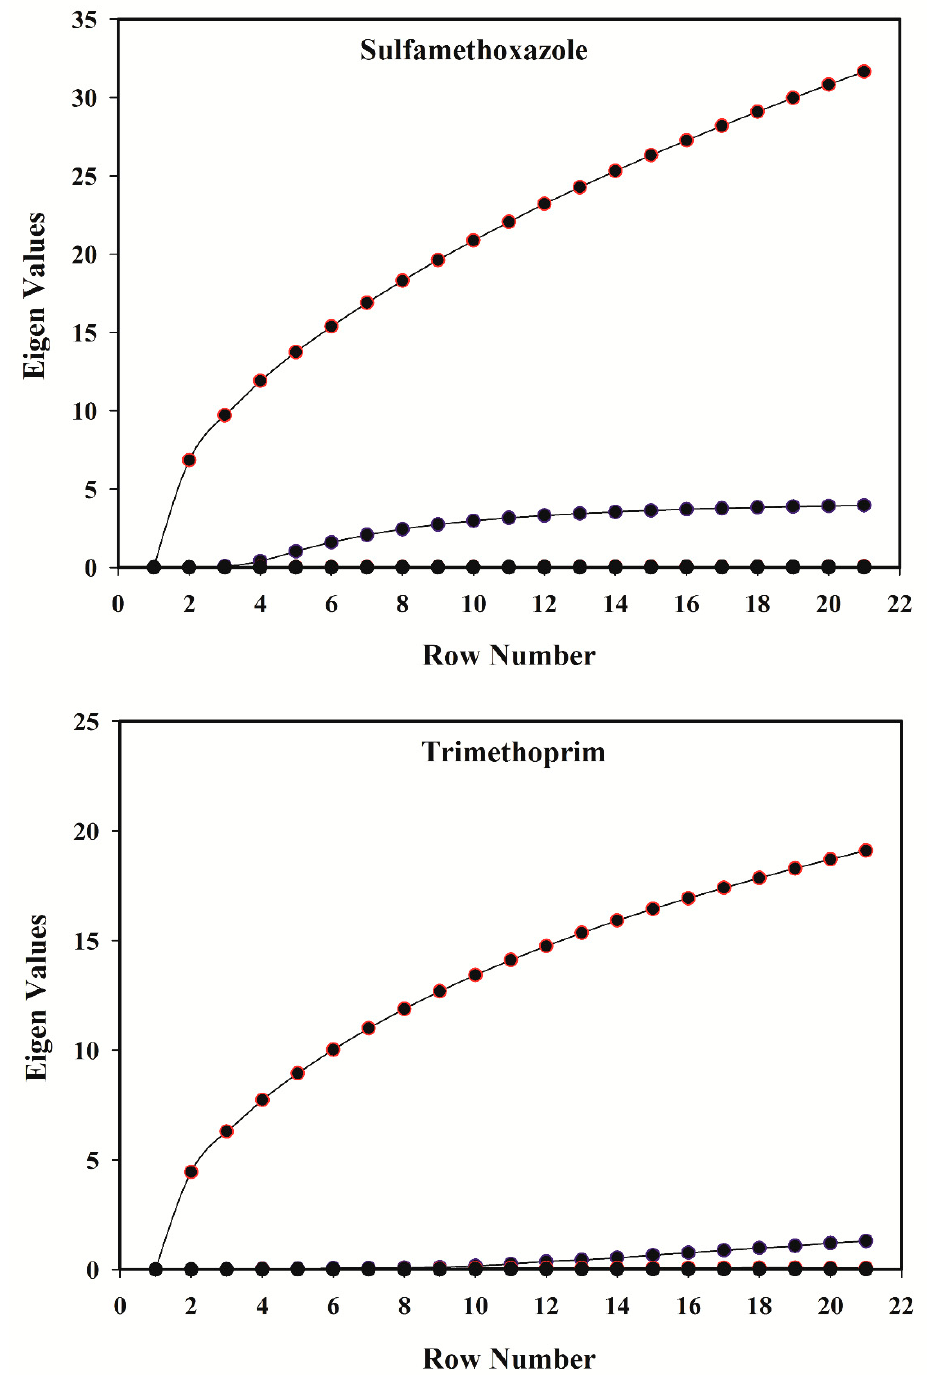
Figure 3. Eigenvalue vs. row number in Evolving Factor Analysis to determine the number of species contributing to the spectral signal of sulfamethoxazole and trimethoprim standard sample solutions.